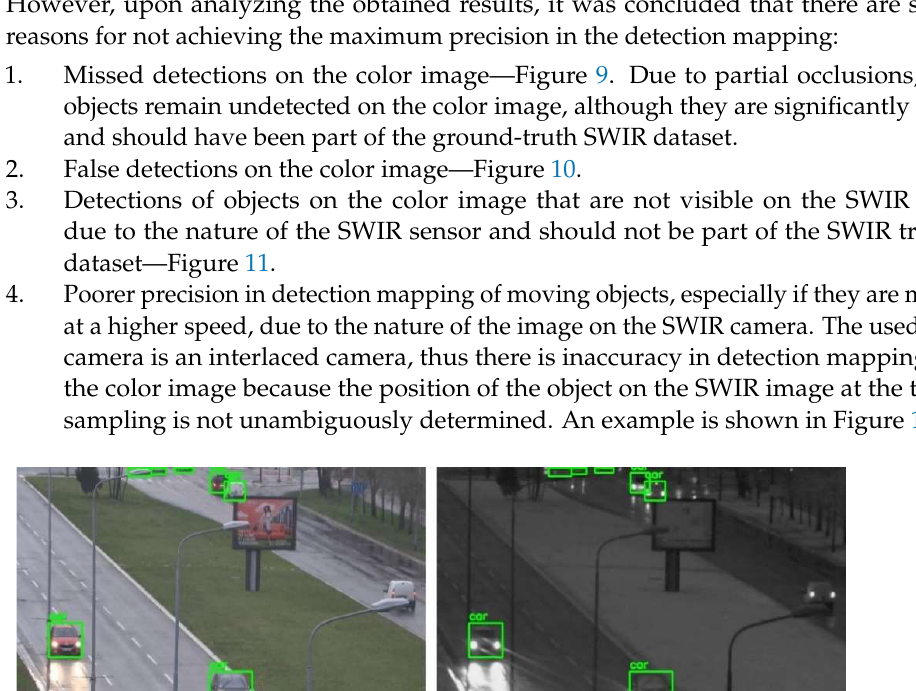
Table 4. Evaluation of the algorithm for detection mapping. Evaluation is performed on labeled SWIR images using COCO_eval library. Small size object presents objects up to 32 × 32 (1024) pixels, medium: from 32 × 32 (1024) to 96 × 96 (9216) pixels, and large objects with size greater than 96 × 96 (9216) pixels. Performance is presented with the Average Precision (AP) 0.5:0.95.